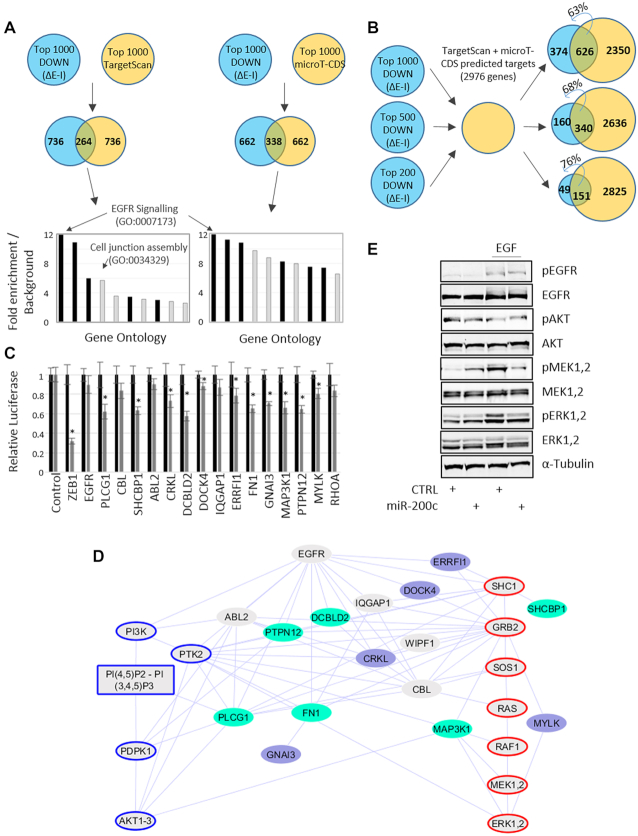
miR-200c directly co-ordinately regulates an EGF signalling network. (A) Putative direct miR-200c target genes were defined as genes in the top 1000 of all negatively post-transcriptionally regulated genes (ΔE – ΔI) that are also in the top 1000 of all predicted miR-200c targets (by TargetScan or microT-CDS). The 10 highest fold enrichments over background for the top ranking gene ontologies are indicated. Black columns represent alternate entries for the EGFR signalling pathway within the GoPanther Gene Ontology database. (B) Overlap between the 1000, 500 and 200 most post-transcriptionally downregulated genes in response to miR-200c and all miR-200c targets that are predicted by both the targetscan and microT-CDS algorithms. (C) 3′UTR-luciferase reporter assays for representative putative miR-200c targets within the EGF signalling network indicate multi-component targeting. Black bars indicate transfection of a control miRNA sequence. Gray bars indicate miR-200c co-transfection. Error bars represent standard deviation, * denote significant (P< 0.05) downregulation of the reporter in response to miR-200c as calculated by t-test. (D) Network representation of miR-200c target genes (shaded blue) within the signalling network downstream of the EGFR. Major signalling pathways leading to AKT (blue outline) and ERK (red outline) activation are adapted from KEGG pathway #04012. Edges connecting nodes represent protein-protein interactions (PPI) from the Integrated Interactions Database (IID) that are supported by experimental evidence. Darker blue shading indicates targets that were more strongly suppressed in 3′UTR luciferase assays. (E) MesHMLE cells were stimulated with EGF and the activation of EGFR, AKT, MEK and ERK (or total protein) were assessed by western blotting in the presence or absence of miR-200c expression.